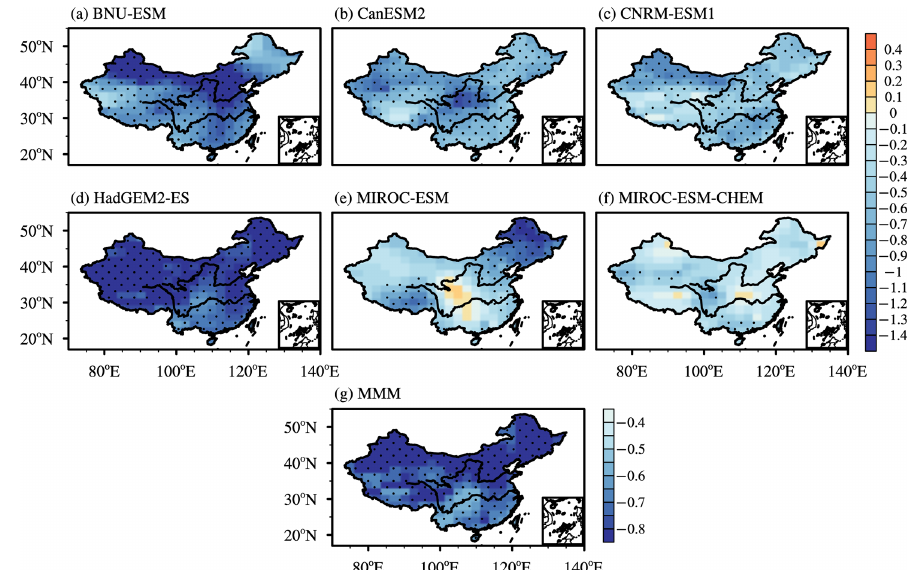
Figure 7. Same as Fig. 6 but in